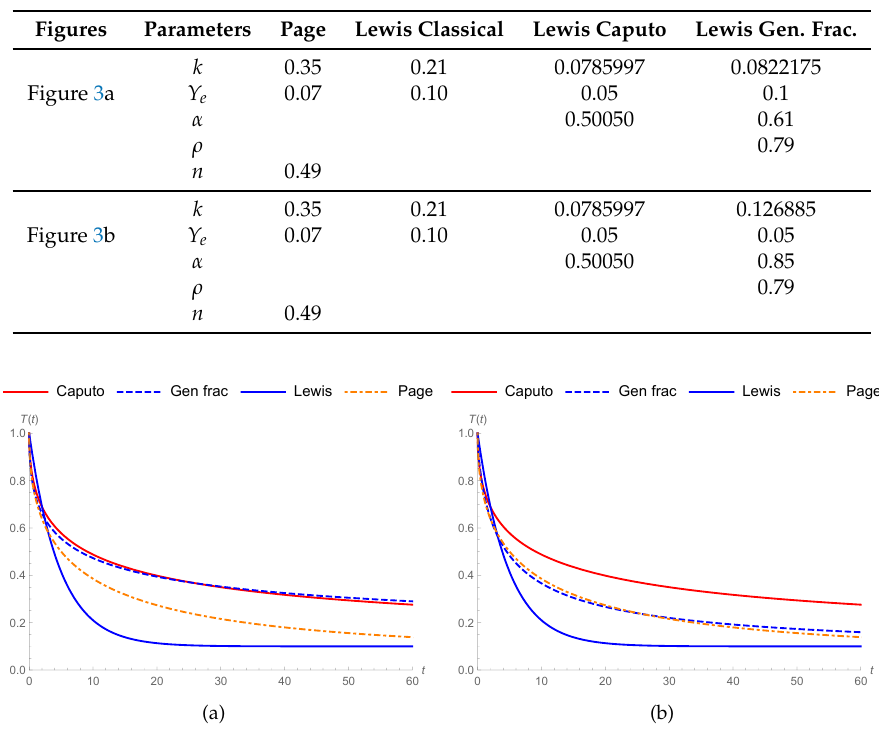
Table 3. Parameter values of models [41].